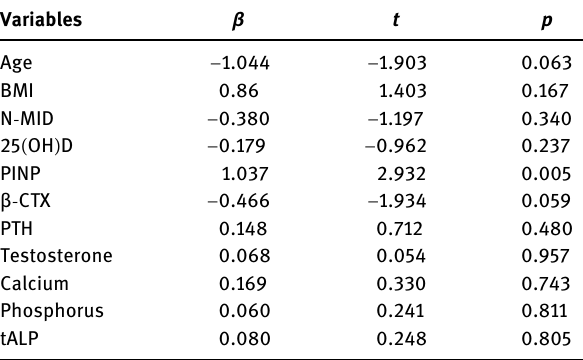
Table 2: Multiple linear regression analysis associated with BMD Variables